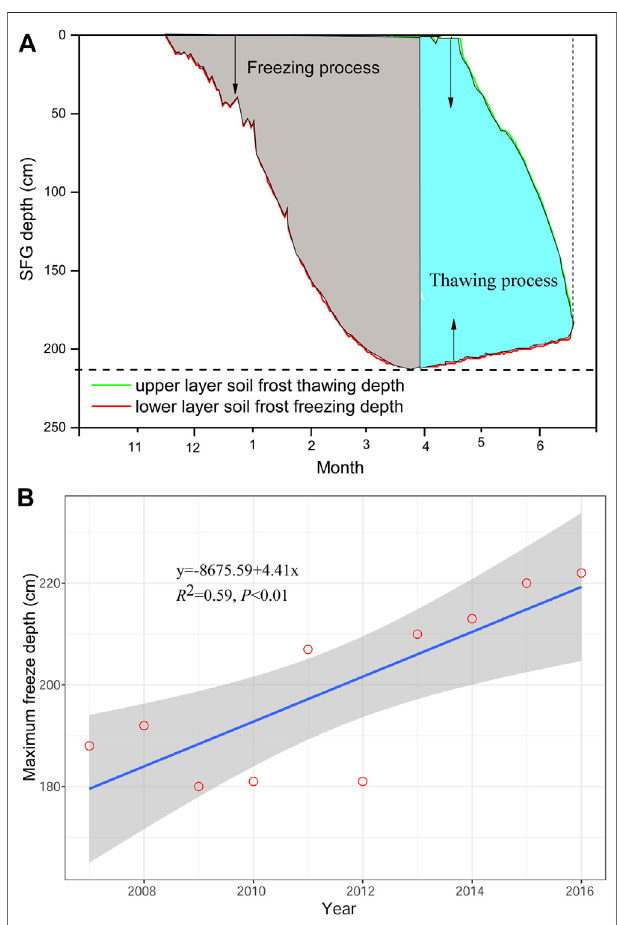
FIGURE 4 | Seasonal (A) and inter-annual variation (B) of seasonally frozen ground (SFG) depth.